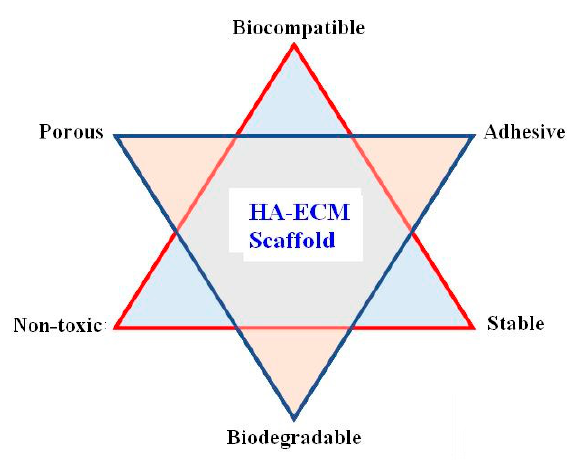
Figure 15. Various properties of ECM scaffolds for bone implant applications.